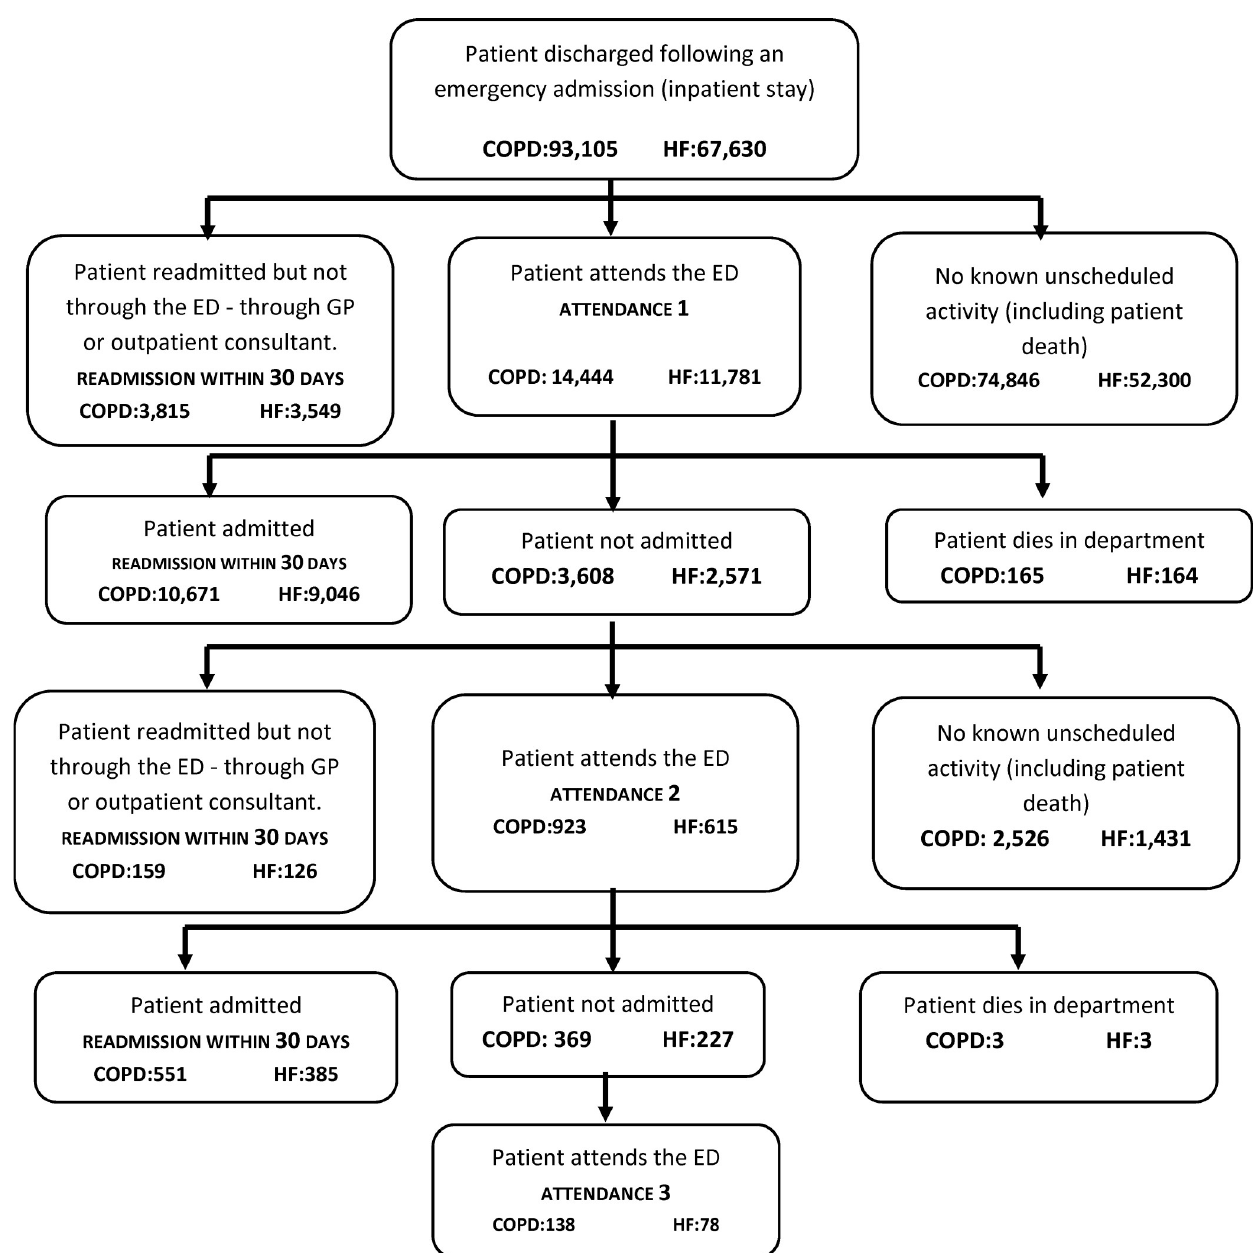
Fig 1. Possible patient routes after discharge from and emergency inpatient stay included in this analysis. Numbers of patients at each stage are shown for each disease. Outcomes within 30 days of the initial discharge were identified.